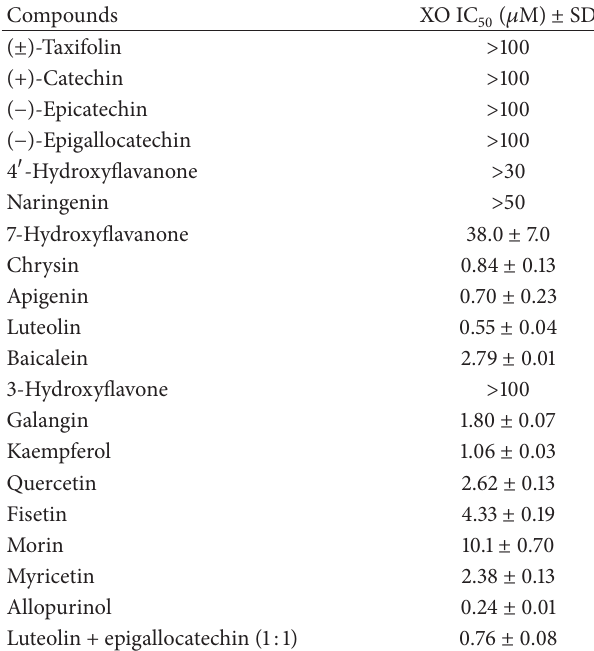
values of flavonoids and allopurinol for inhibition of